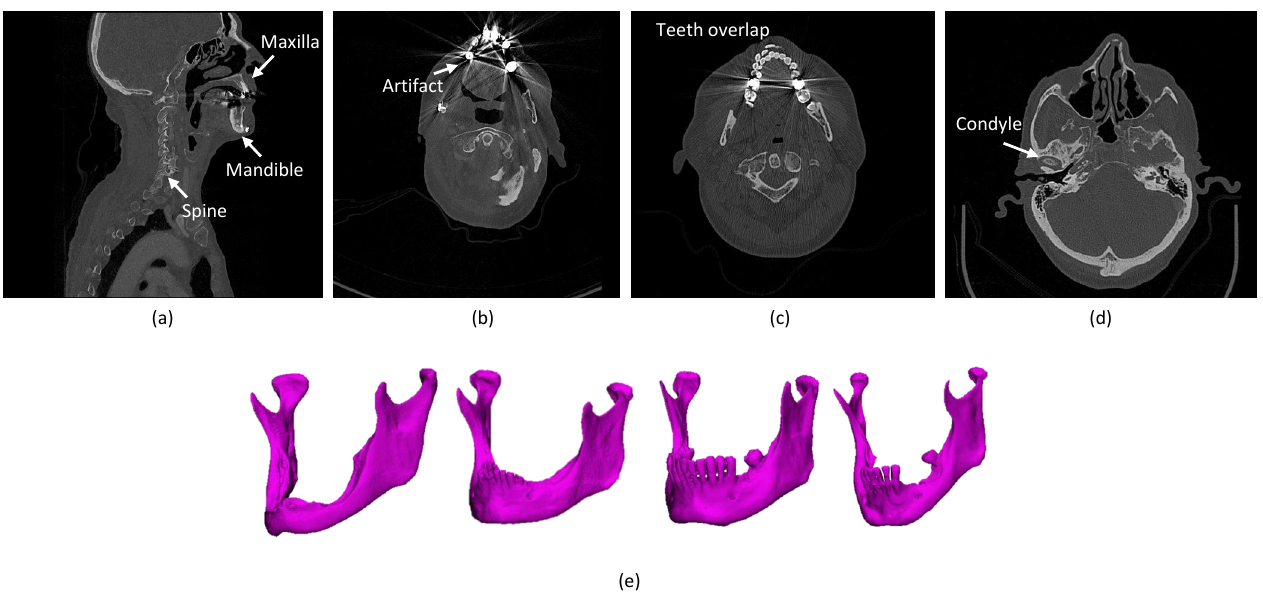
Figure 1. Examples of typical cases that challenge accurate mandible segmentation. ( a ) Various bone-structured organs in the H&N scans. ( b ) Metal artifacts. ( c ) Presence of inferior and superior teeth in the same slice. ( d ) Lower intensity in the condyles. ( e ) Large variation in mandibles between